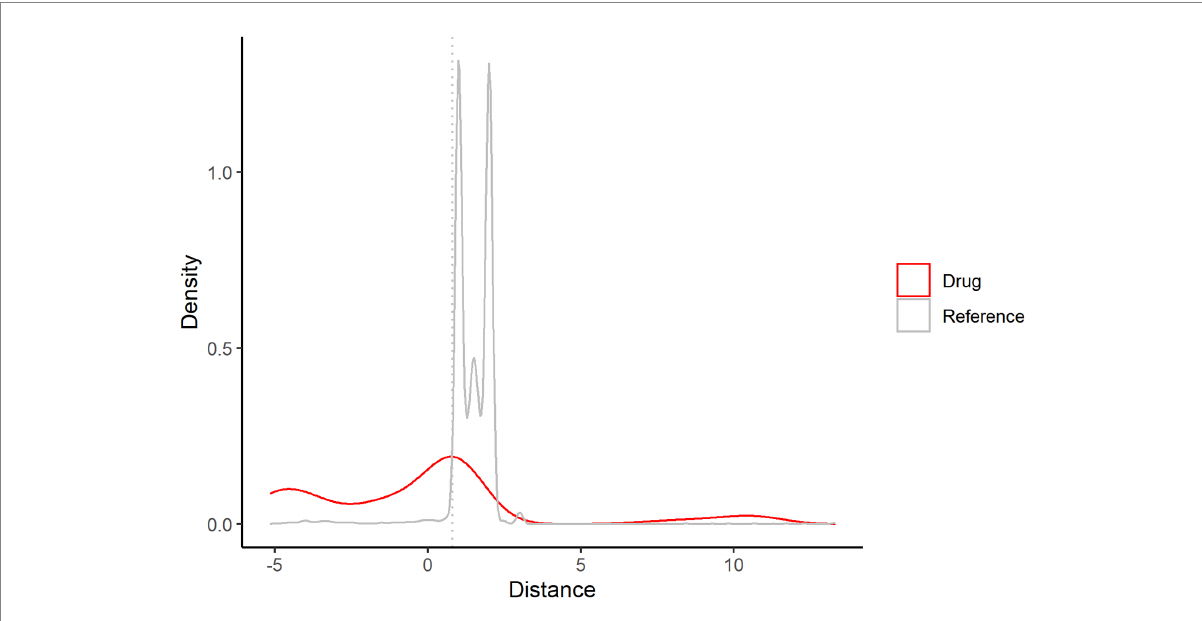
FIGURE 9 Distance density map of 484 drugs and ischemic